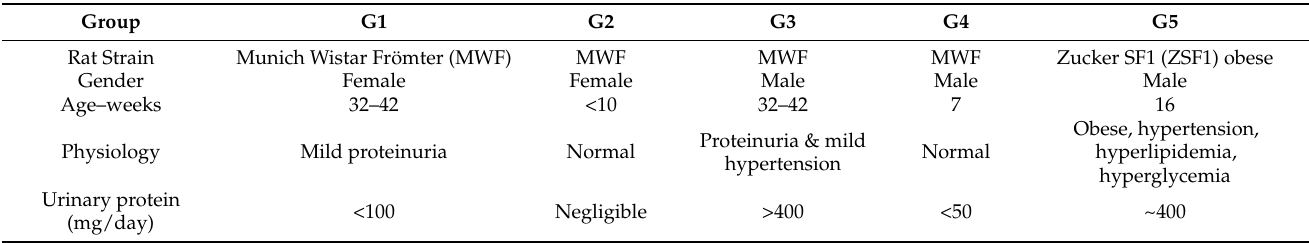
Table 1. Different specifications of the five groups of